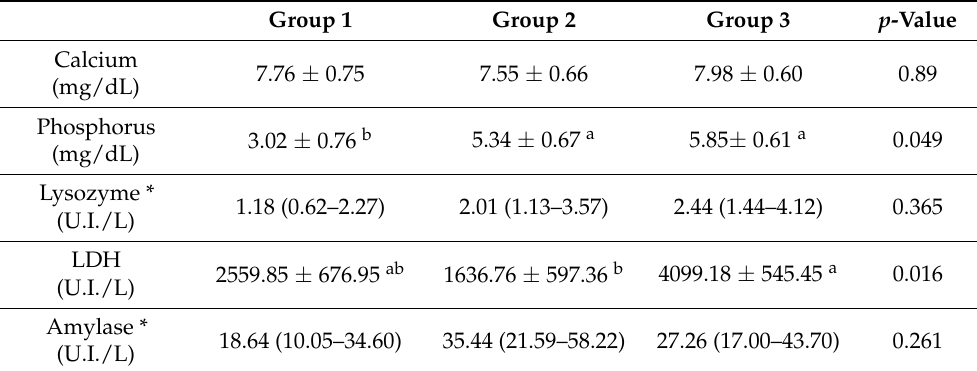
Table 4. Salivary biochemistry (mean ± standard error) in healthy dogs and dogs with periodontal